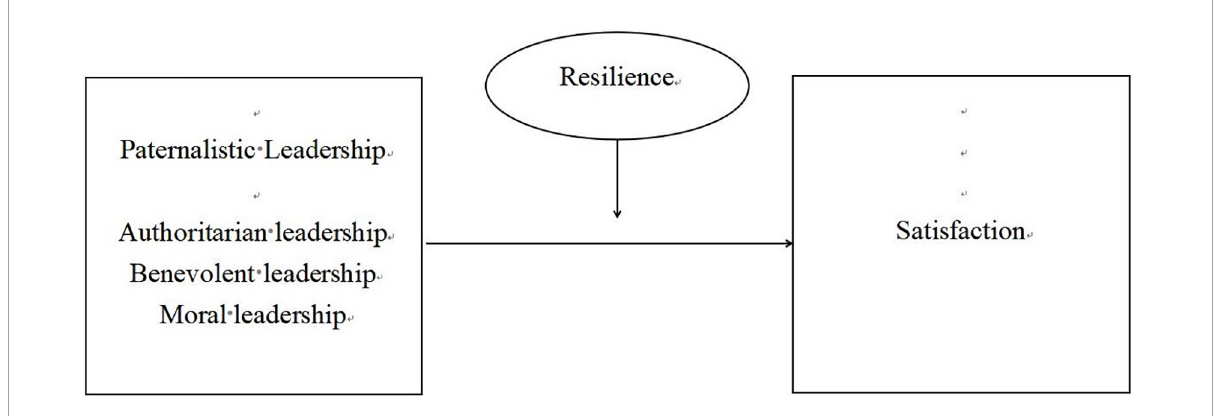
FIGURE1 The research model.